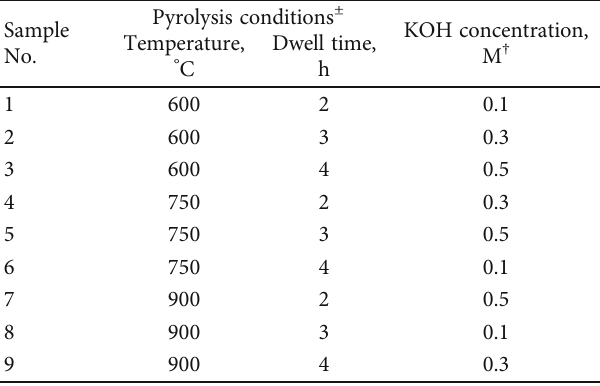
Table 1: Taguchi L experimental design used to prepare chars 9 (CSS) and activated carbons (CSK) from the coconut shell biomass for the separation of itaconic acid from aqueous